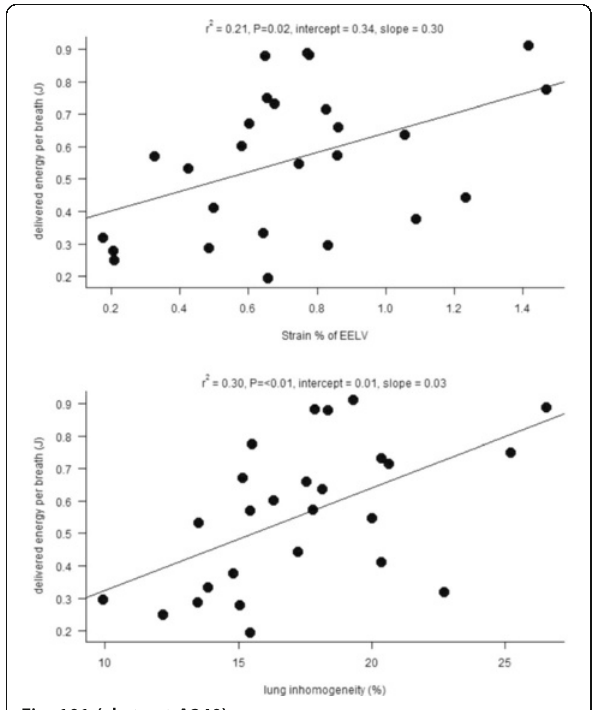
(Fig. 101, upper panel) and inhomogeneity (Fig. 101, lower panel); the relationship between delivered energy and intratidal collapse- decollapse did not reach statististical significance (r 2 =0.10, p =0.11). Conclusions Greater lung strain and lung inhomogeneities increase the energy delivered to the respiratory system by the tidal